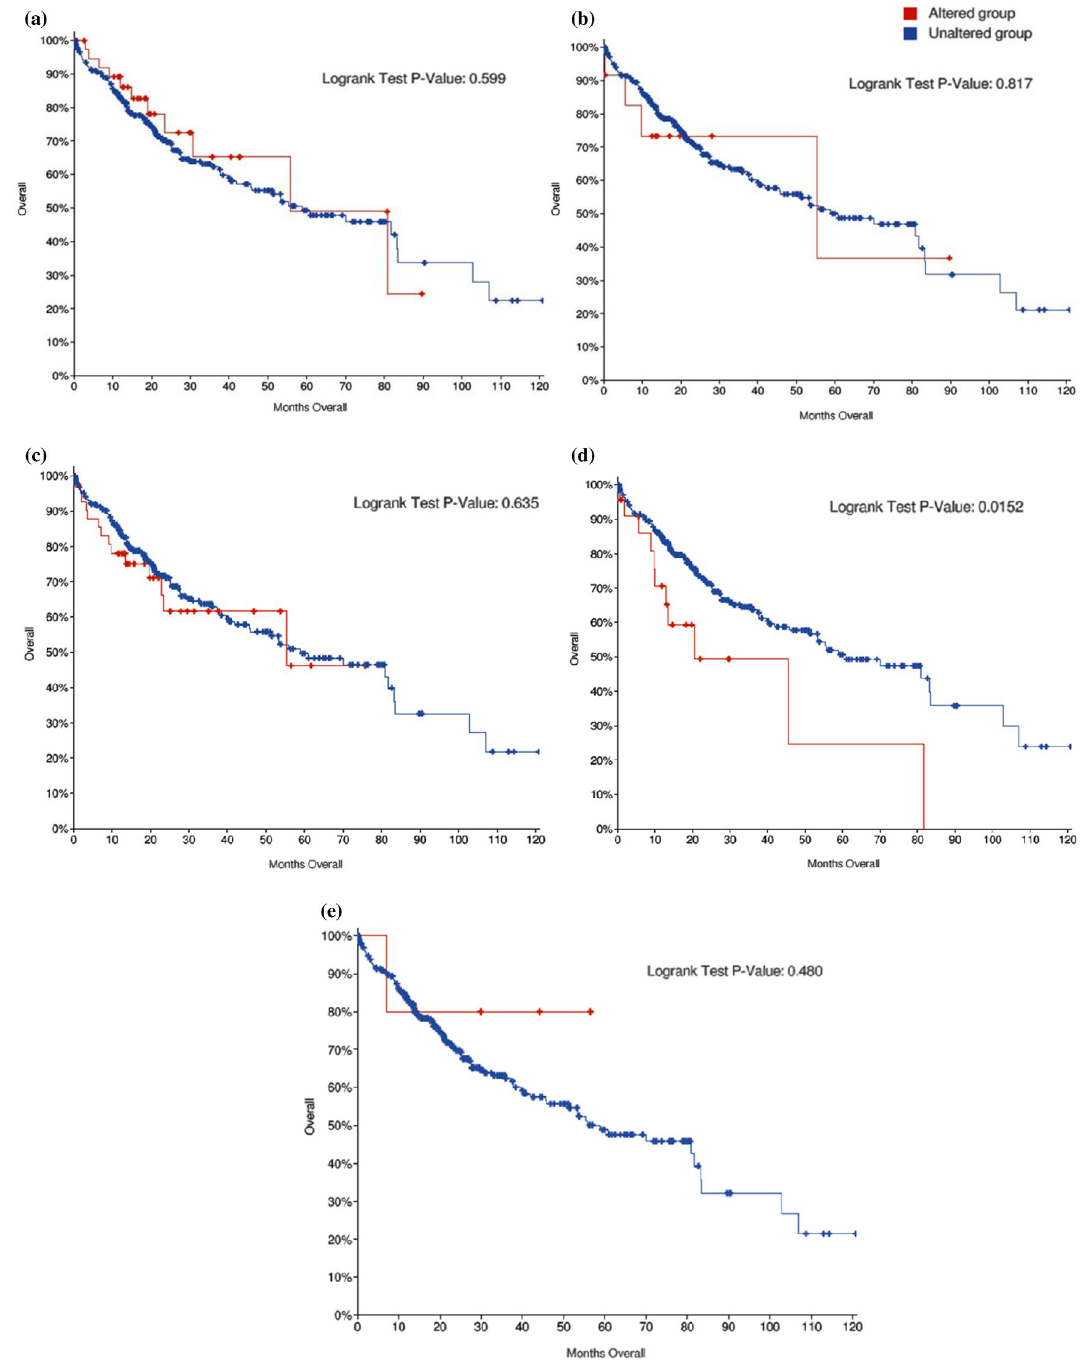
Figure 7. Survival curves retrieved from TCGA database for all the studied genes; ( a ) DPT ( b ) RUNX3 ( c ) p16 ( d ) RASSF1A and ( e ) SOCS1